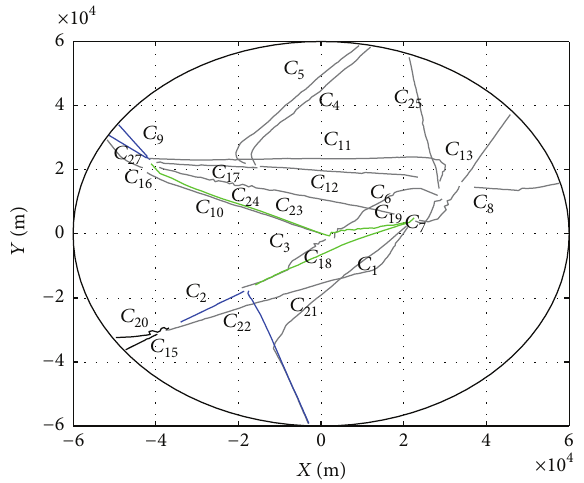
Figure 9: Intended route set represented by green, blue, and black lines.